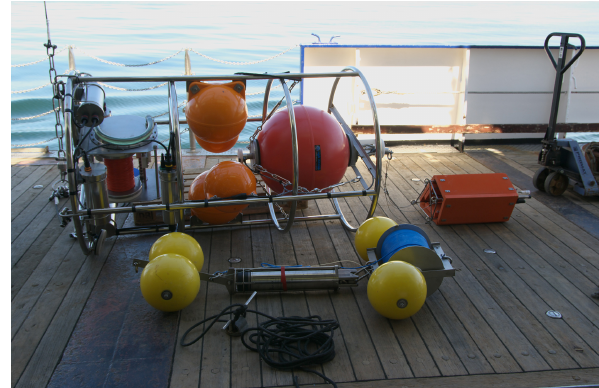
Figure 6. Mooring components laid out on deck before the second deployment in July 2010. Recovery system with acoustic releaser (front), underwater winch (back left) and profiling platform with instruments (back right).